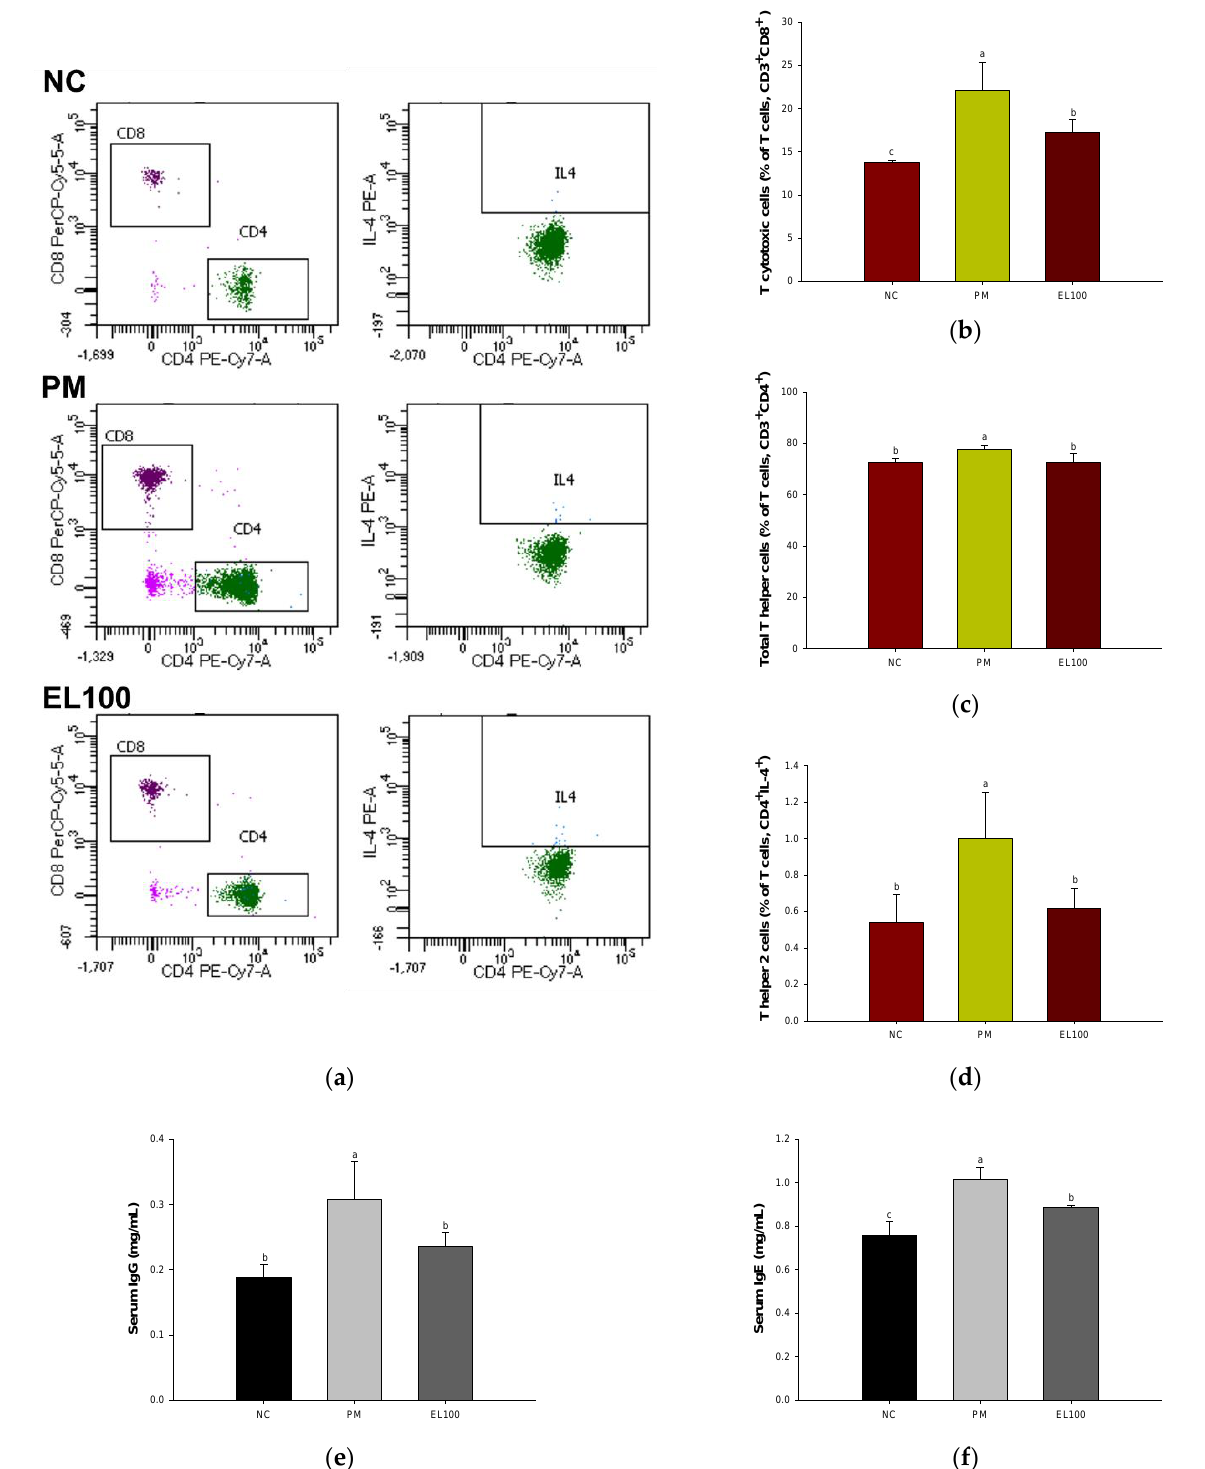
Figure 3. Protective effect of extract of Lonicera japonica on PM 2.5 -induced inflammatory response. ( a ) Flow cytometer analysis; ( b ) T cytotoxicity cells; ( c ) Total T helper cells; ( d ) T helper 2 cells; ( e ) IgG contents; ( f ) IgE contents. Results shown are mean ± SD ( n = 3). Data were statistically represented at p < 0.05, and different lowercase letters indicate statistical significance.